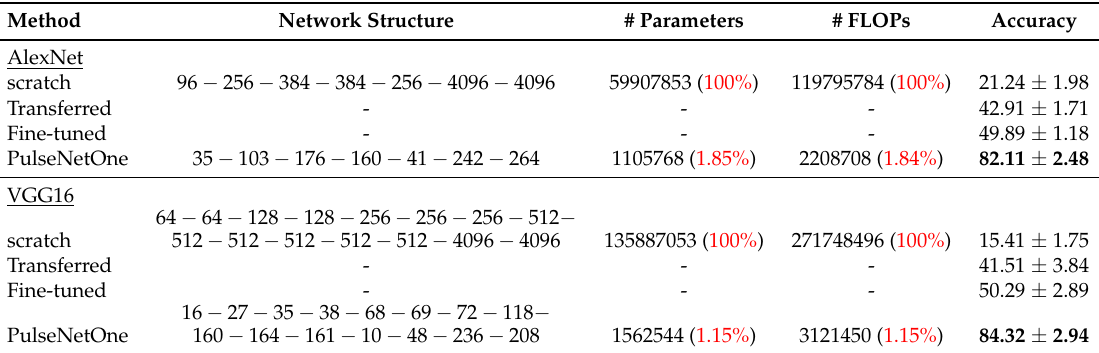
Table 10. Overall accuracies and standard deviations (%) of different CNNs methods along with PulseNetOne on the SUN397 dataset. The entries in bold show the method with the best classification for the network, while the percentage of the original network is highlighted in